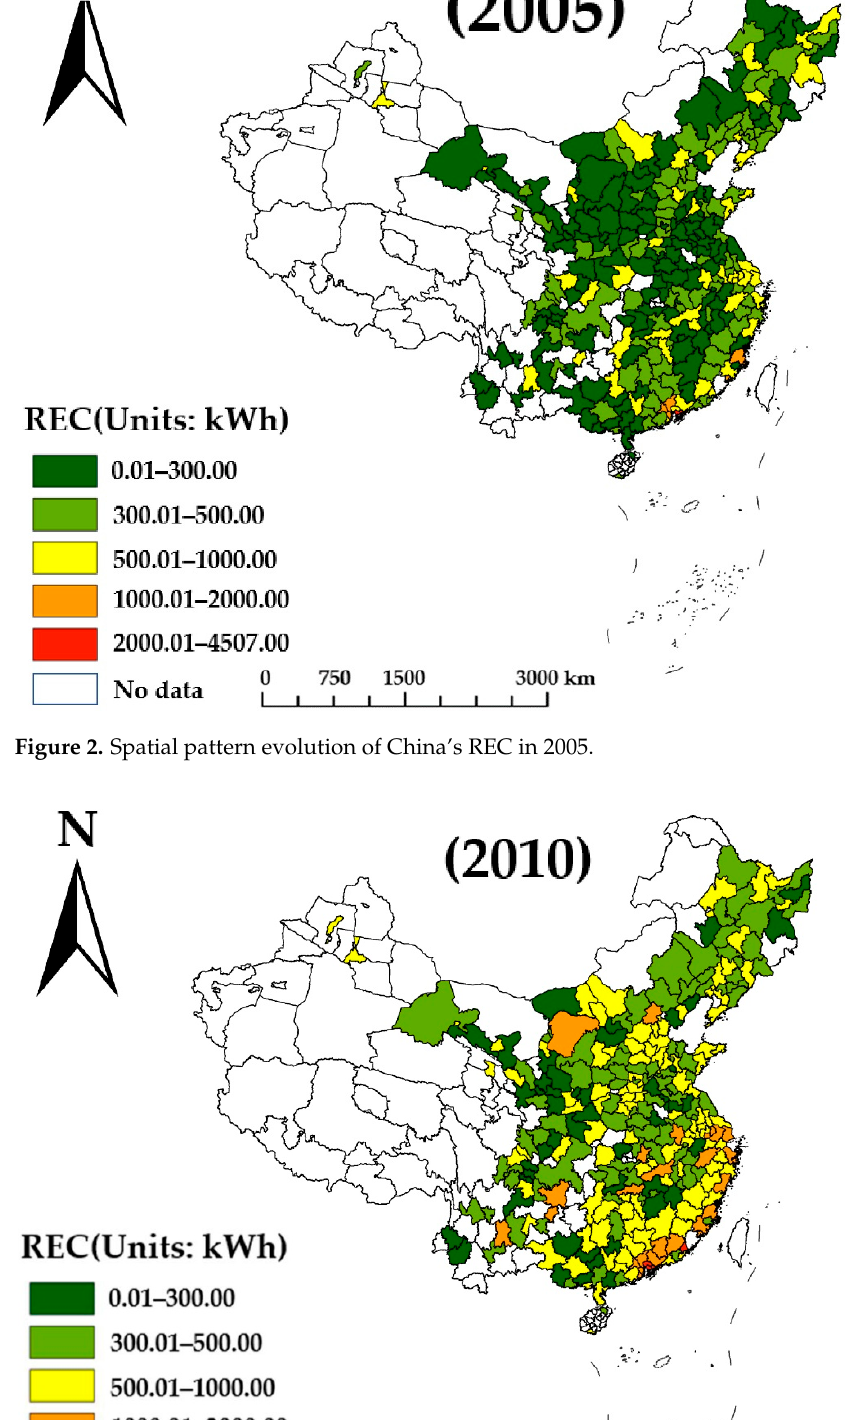
Figure 4. Spatial pattern evolution of China’s REC in 2016. 3.2. Spatial Correlation Analysis According to the approach above, we calculate the global Moran’s I index of China’s REC from 2005 to 2016, which ranged from 0.159 to 0.272 (see Table 6). As shown in Table